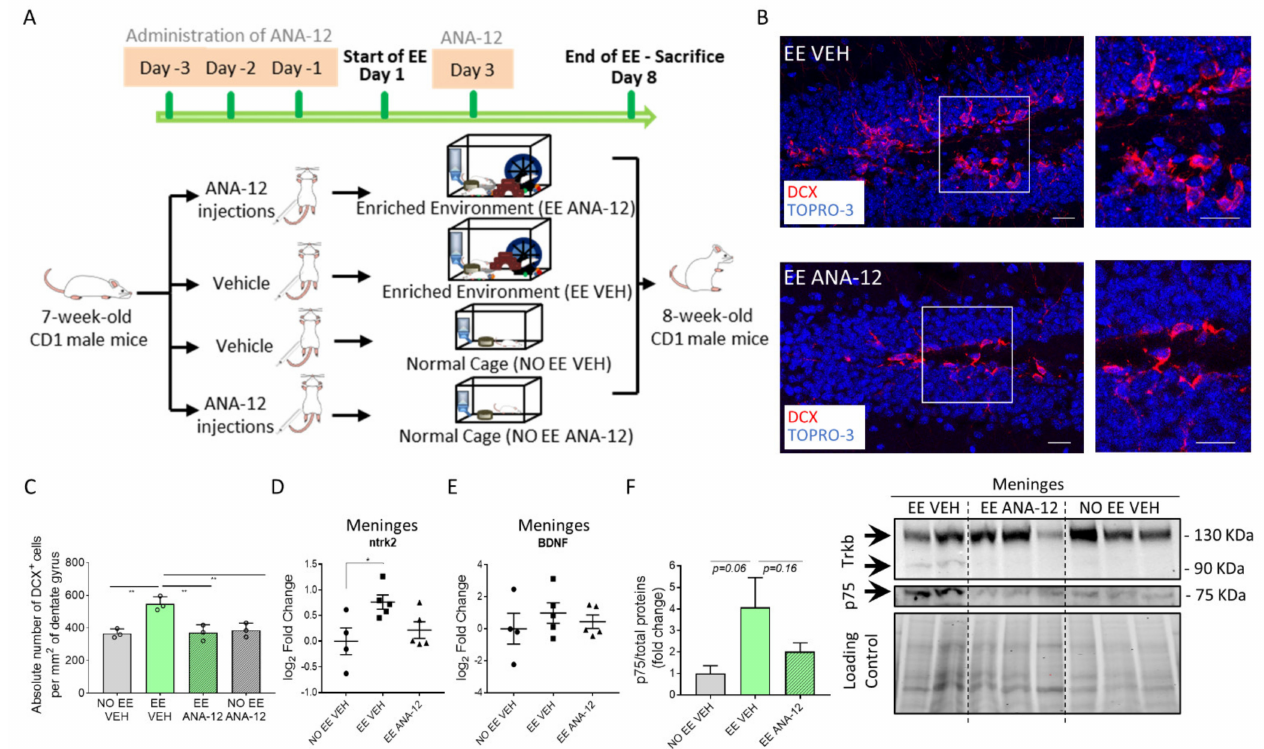
Figure 3. ANA-12 inhibits hippocampal neurogenesis and impacts BDNF-TrkB signaling in the meninges. ( A ) Schematic representation of the experimental design used for EE exposure and TrkB inhibitor ANA-12 administration in CD1 mice. ( B ) Sagittal brain sections of CD1 mice, showing hippocampal DCX + (red) cells in animals exposed to the EE and administered only the vehicle (EE VEH) and animals exposed to the EE and administered with the TrkB inhibitor ANA-12 (EE ANA-12). A white box highlights a dentate gyrus (DG) zone, reported as a magnification on the right panel. ( C ) Graph showing the number of DCX + cells per mm 2 of the DG in animals subjected to the EE or not and administered with the vehicle or ANA-12 (NO EE VEH, EE VEH, EE ANA-12 and NO EE ANA-12). ( D ) Graph depicting gene expression analysis for ntrk2 (TrkB) in NO EE VEH, EE VEH and EE ANA-12 samples. Expression levels are reported as the log 2 fold change with respect to NO EE VEH. ( E ) Graph depicting gene expression analysis for BDNF in NO EE VEH, EE VEH and EE ANA-12 mice. Expression levels are reported as the log 2 fold change with respect to the NO EE VEH mice. ( F ) Graph showing the differential fold change in protein expression for the p75 protein in NO EE VEH, EE VEH and EE ANA-12 mice with respect to the NO EE VEH samples (left panel). A representative western blot analysis of the mouse brain meningeal protein extracts shows the presence of TrkB and p75 proteins in the EE VEH, EE ANA-12 and NO EE VEH samples (right). In the EE VEH samples, one additional TrkB protein isoform was identified. Data are presented as the mean ± SEM. * p value ≤ 0.05. ** p value ≤ 0.01. In ( B ), the nuclei are in blue (TOPRO-3 nuclear staining). ( B ) shows the maximum intensity projections of the z-stack confocal images. The scale bars represent 20 µ